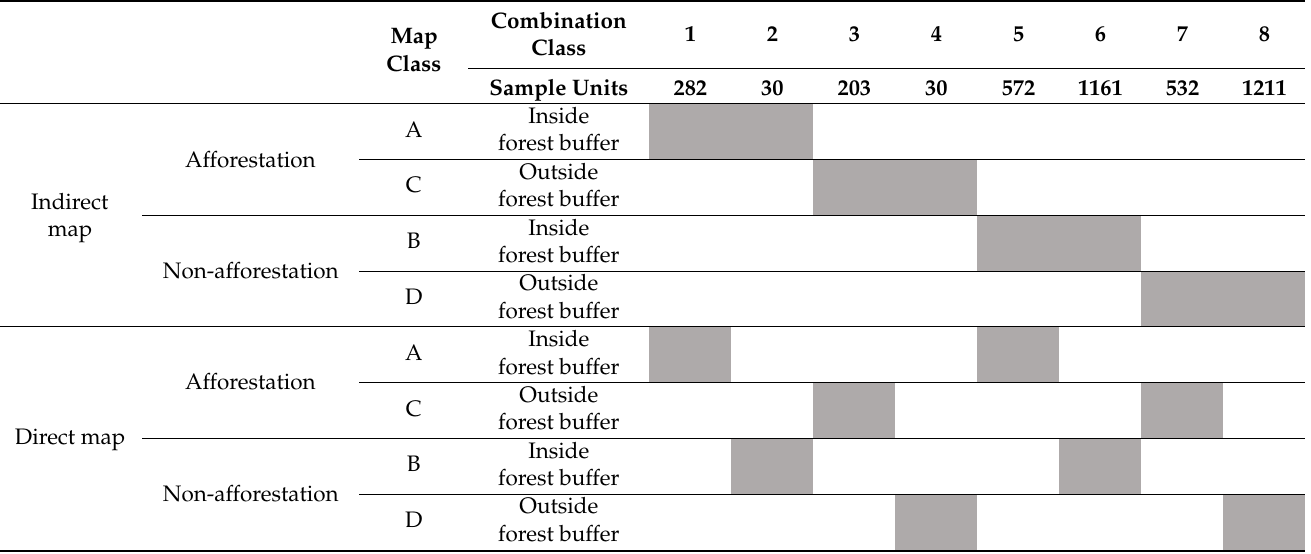
Table 2. Number of validation dataset sample units per combination class (highlighted in